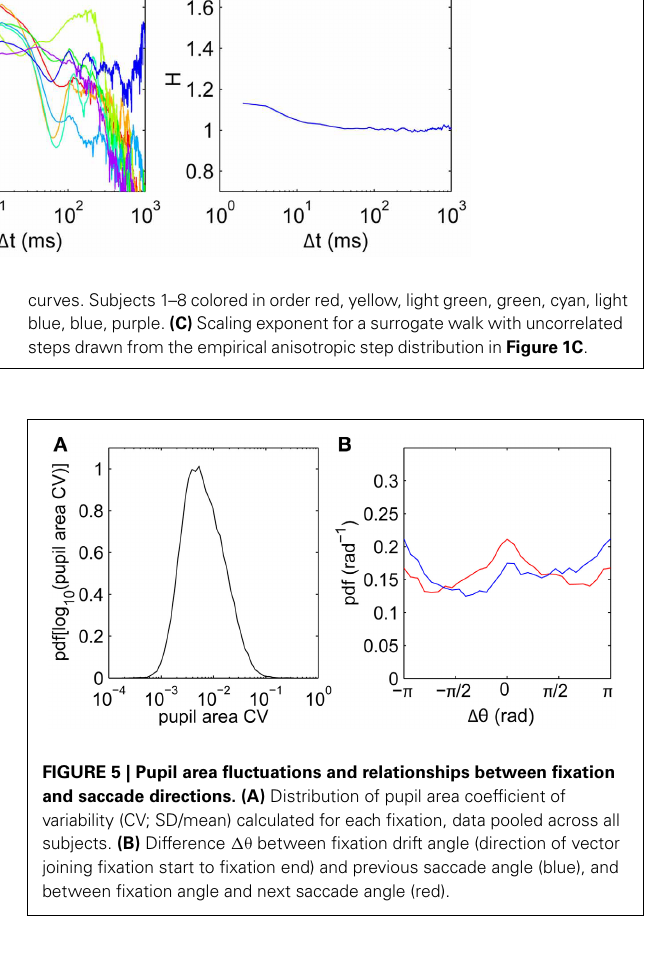
FIGURE 5 | Pupil area fluctuations and relationships between fixation and saccade directions. (A) Distribution of pupil area coefficient of variability (CV; SD/mean) calculated for each fixation, data pooled across all subjects. (B) Difference (cid:2) θ between fixation drift angle (direction of vector joining fixation start to fixation end) and previous saccade angle (blue), and between fixation angle and next saccade angle